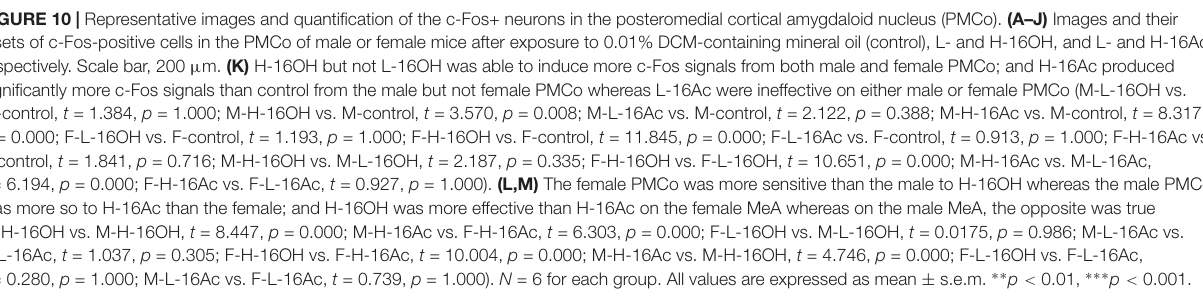
FIGURE 10 | Representative images and quantification of the c-Fos+ neurons in the posteromedial cortical amygdaloid nucleus (PMCo). (A–J) Images and their insets of c-Fos-positive cells in the PMCo of male or female mice after exposure to 0.01% DCM-containing mineral oil (control), L- and H-16OH, and L- and H-16Ac, respectively. Scale bar, 200 µ m. (K) H-16OH but not L-16OH was able to induce more c-Fos signals from both male and female PMCo; and H-16Ac produced significantly more c-Fos signals than control from the male but not female PMCo whereas L-16Ac were ineffective on either male or female PMCo (M-L-16OH vs. M-control, t = 1.384, p = 1.000; M-H-16OH vs. M-control, t = 3.570, p = 0.008; M-L-16Ac vs. M-control, t = 2.122, p = 0.388; M-H-16Ac vs. M-control, t = 8.317, p = 0.000; F-L-16OH vs. F-control, t = 1.193, p = 1.000; F-H-16OH vs. F-control, t = 11.845, p = 0.000; F-L-16Ac vs. F-control, t = 0.913, p = 1.000; F-H-16Ac vs. F-control, t = 1.841, p = 0.716; M-H-16OH vs. M-L-16OH, t = 2.187, p = 0.335; F-H-16OH vs. F-L-16OH, t = 10.651, p = 0.000; M-H-16Ac vs. M-L-16Ac, t = 6.194, p = 0.000; F-H-16Ac vs. F-L-16Ac, t = 0.927, p = 1.000). (L,M) The female PMCo was more sensitive than the male to H-16OH whereas the male PMCo was more so to H-16Ac than the female; and H-16OH was more effective than H-16Ac on the female MeA whereas on the male MeA, the opposite was true (F-H-16OH vs. M-H-16OH, t = 8.447, p = 0.000; M-H-16Ac vs. F-H-16Ac, t = 6.303, p = 0.000; F-L-16OH vs. M-L-16OH, t = 0.0175, p = 0.986; M-L-16Ac vs. F-L-16Ac, t = 1.037, p = 0.305; F-H-16OH vs. F-H-16Ac, t = 10.004, p = 0.000; M-H-16Ac vs. M-H-16OH, t = 4.746, p = 0.000; F-L-16OH vs. F-L-16Ac, t = 0.280, p = 1.000; M-L-16Ac vs. F-L-16Ac, t = 0.739, p = 1.000). N = 6 for each group. All values are expressed as mean ± s.e.m. ∗∗ p < 0.01, ∗∗∗ p <